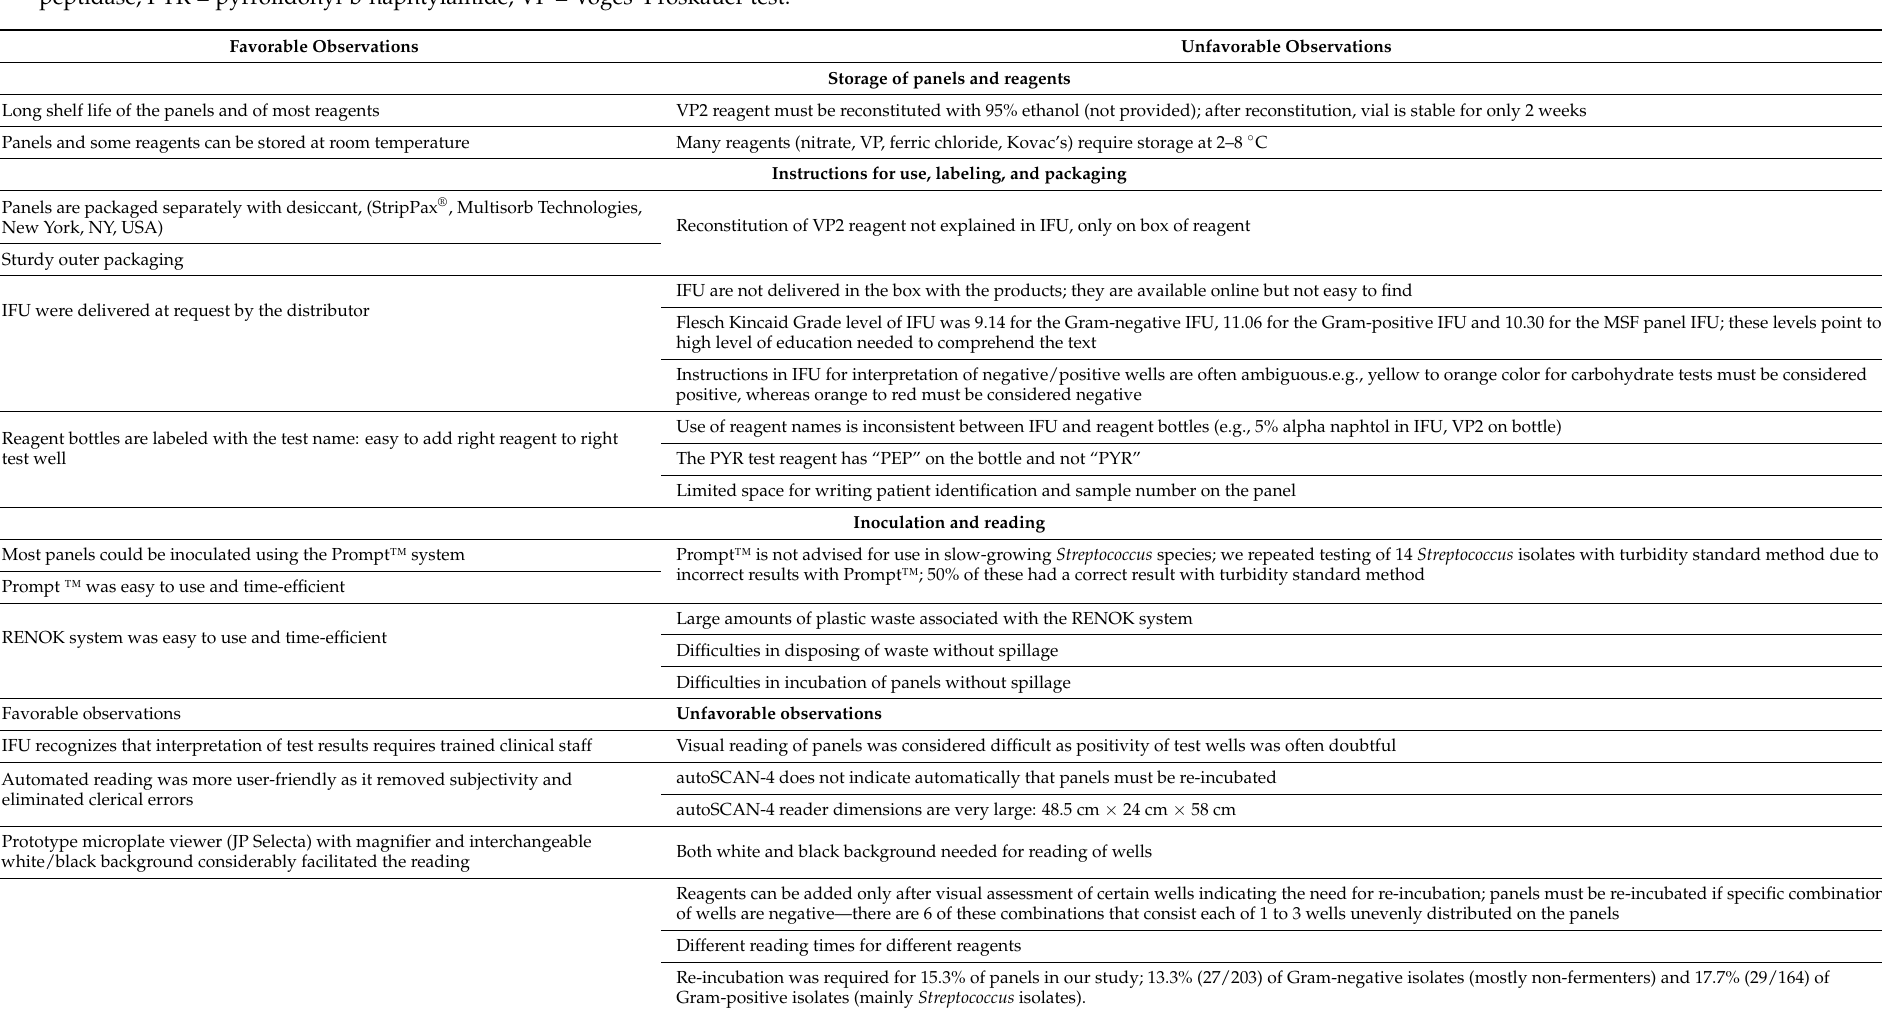
Table 7. Ease-of-use assessment with a focus on use in low resource settings of different aspects of the MicroScan identification panels. Abbreviations: IFU = instructions for use; PEP = peptidase; PYR = pyrrolidonyl-b-naphtylamide; VP = Voges–Proskauer